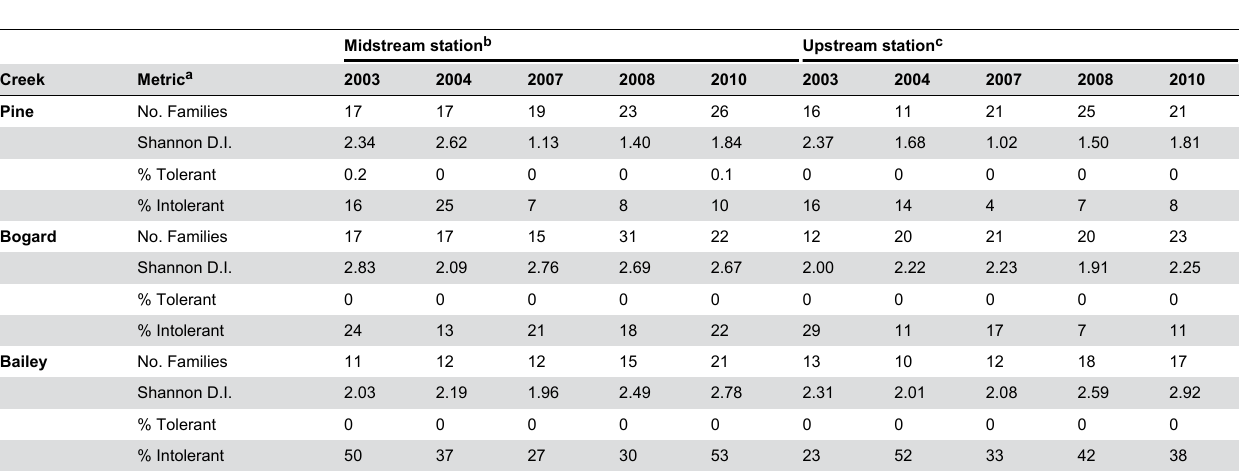
Table 8. Aquatic macroinvertebrate metrics for Pine, Bogard, and Bailey Creek samples collected in June-July of 2003-2004, 2007-2008, and 2010.